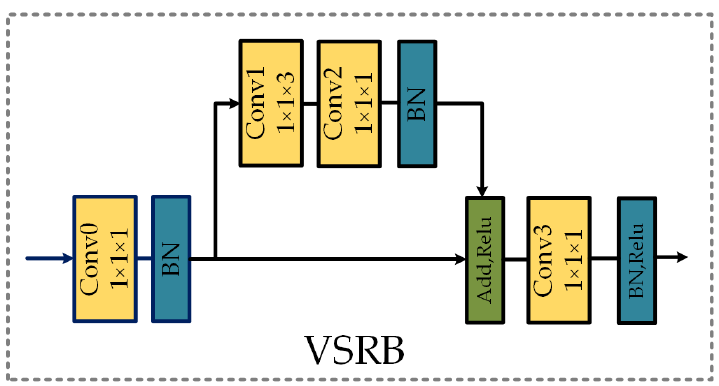
Figure 4. The variable spectral residual block used for replacing the convolution operation in each subnetwork. BN represents the batch normalization, and Conv denotes the convolutional